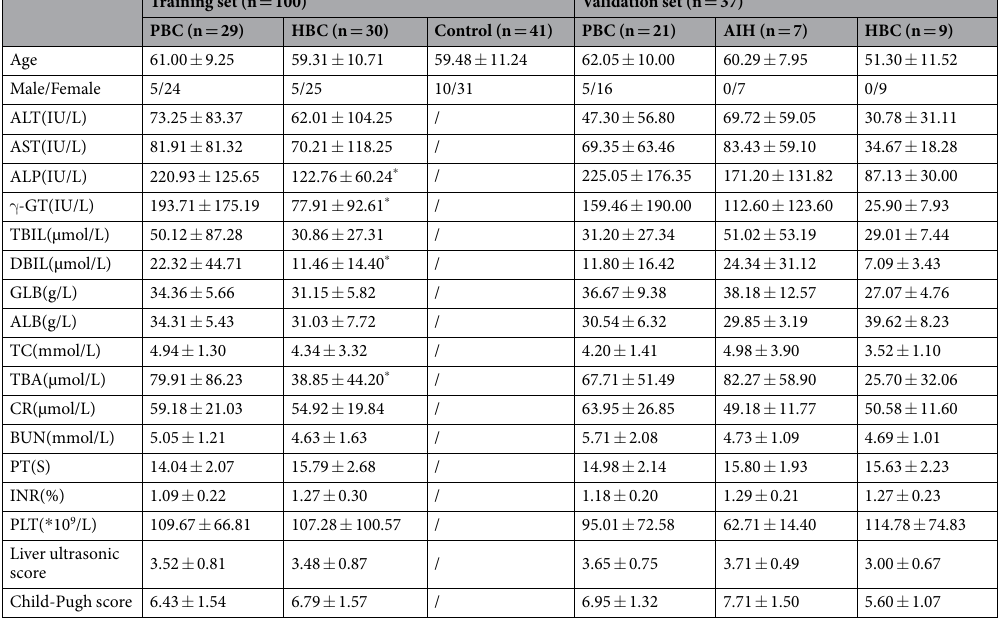
Table 1. Baseline clinical characteristics of the patients and controls in the training and validation sets. * P < 0.05 ALT: alanine aminotransferase, AST: aspartate aminotransferase, ALP: alkaline phosphatase, γ -GT: international normalized ratio, PLT: platelet